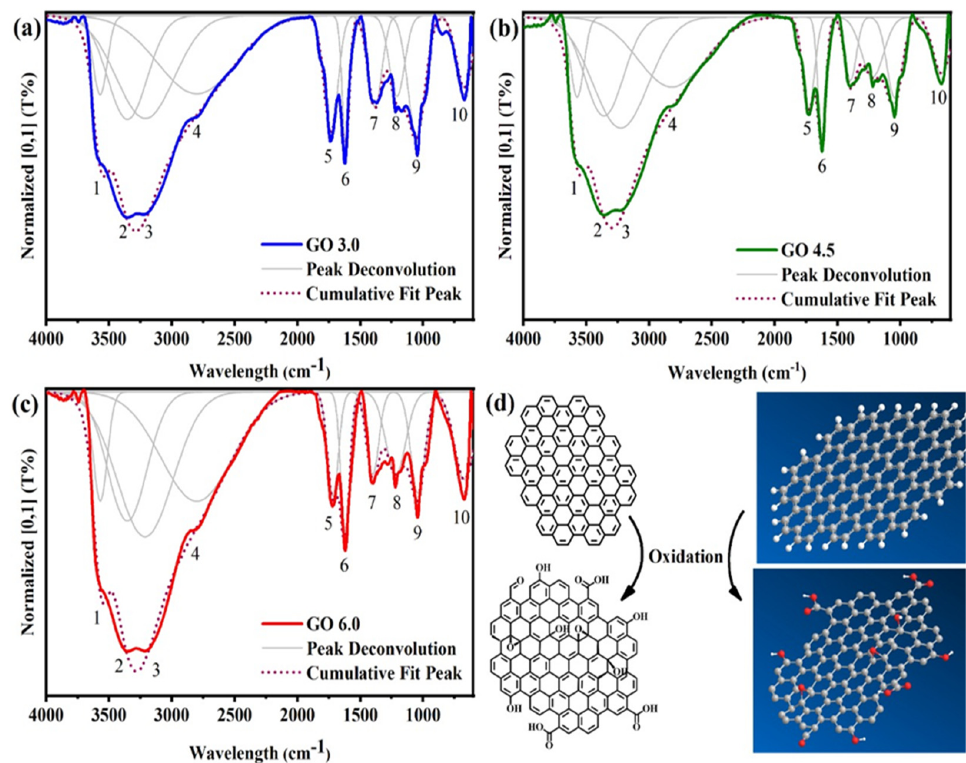
Figure 3. FTIR spectra for samples of ( a ) GO 3.0 g, ( b ) GO 4.5 g, ( c ) GO 6.0 g and ( d ) a representation of the morphological modification on the graphitic layer induced by oxidation.